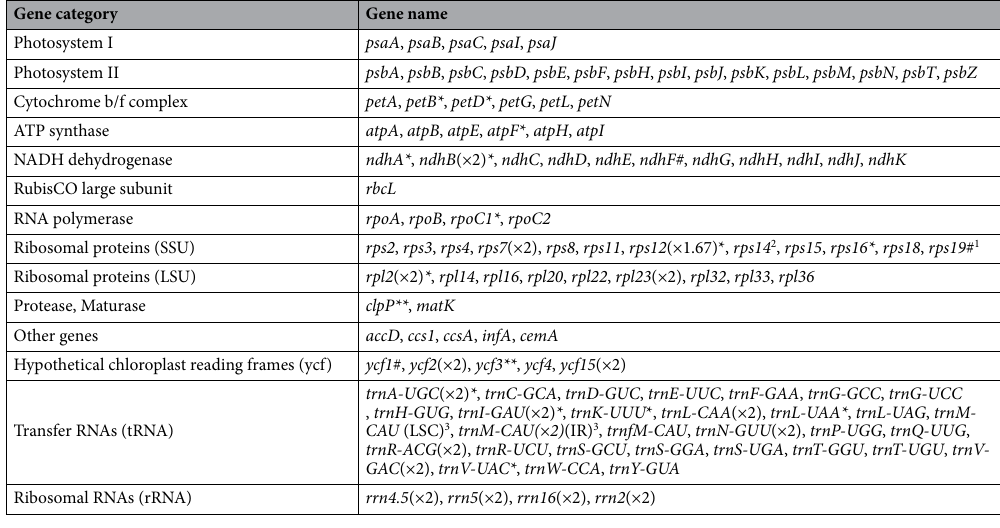
Table 2. The gene contents of 52 Gesneriaceae plastomes analyzed in this study. (×2): gene duplicated in IRs. *Gene with one intron. **Gene with two introns. (×1.67): the trans-splicing gene, rps12 , which possesses three exons with two of which duplicated in IRs, and thus the gene was marked as ×1.67 copies. # The partially duplicated genes locating on the IR/SC boundaries. 1 Rps19 of some Paraboea species is not partially duplicated by IRs. 2 Rps14 is loss in Oreocharis mileensis . 3 The trnM-CAU gene in LSC is different in sequence from the trnM-CAU in IRs, and thus regarded as distinct genes.